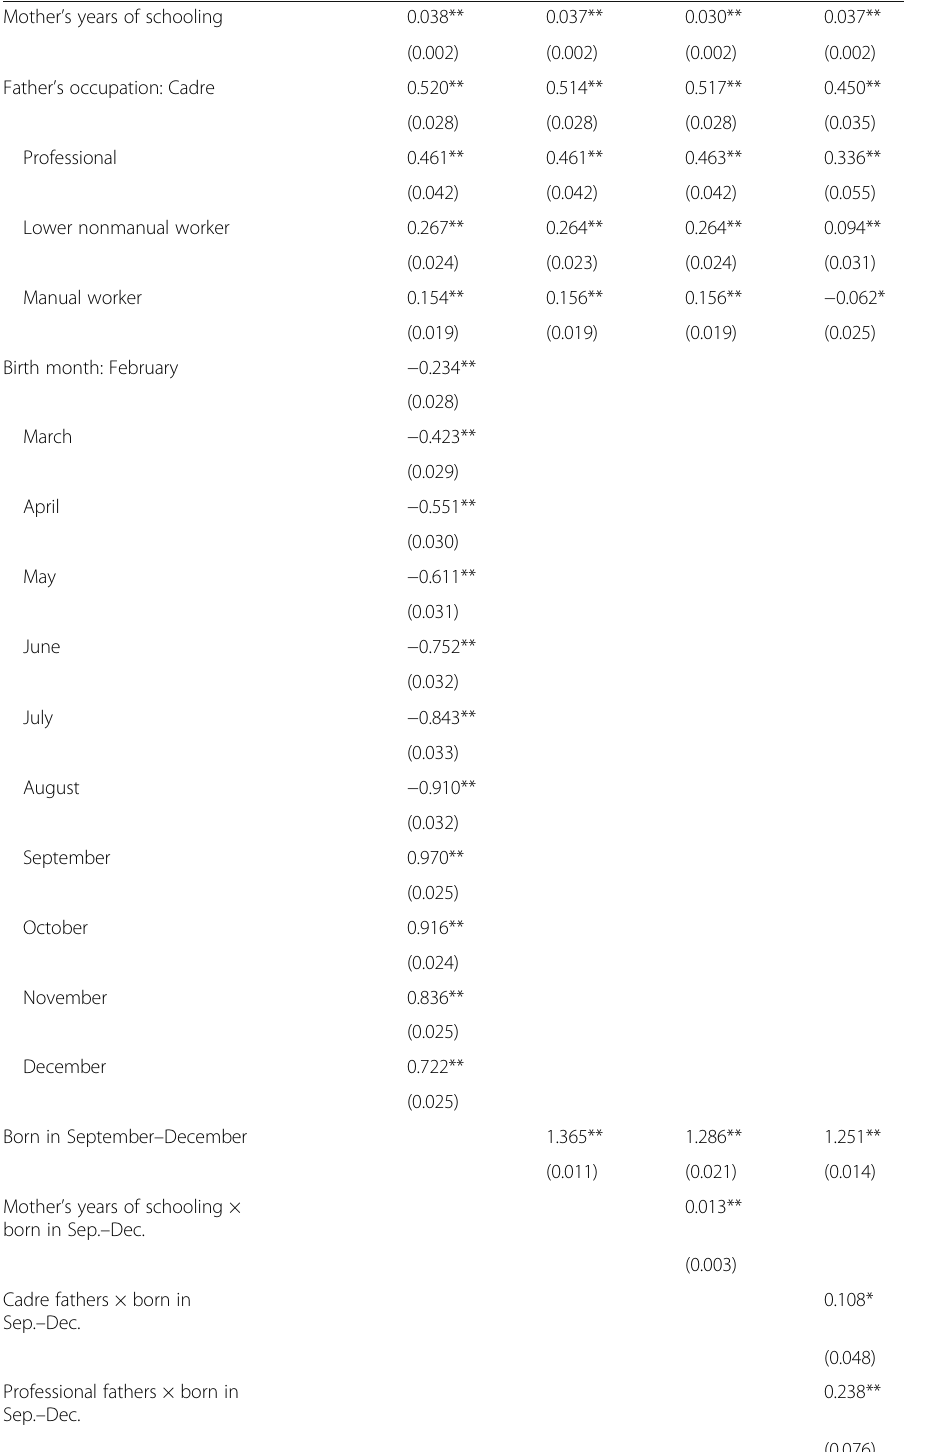
Table 1 The logistic regression of early school entry for one year on child ’ s birth